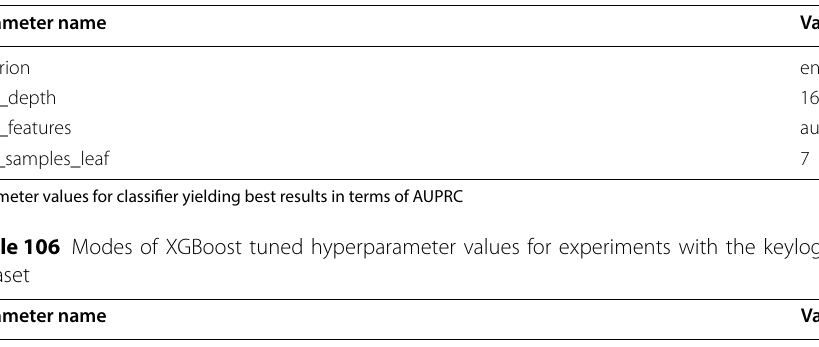
Table 105 Modes of DT tuned hyperparameter values for experiments with the keylogging dataset